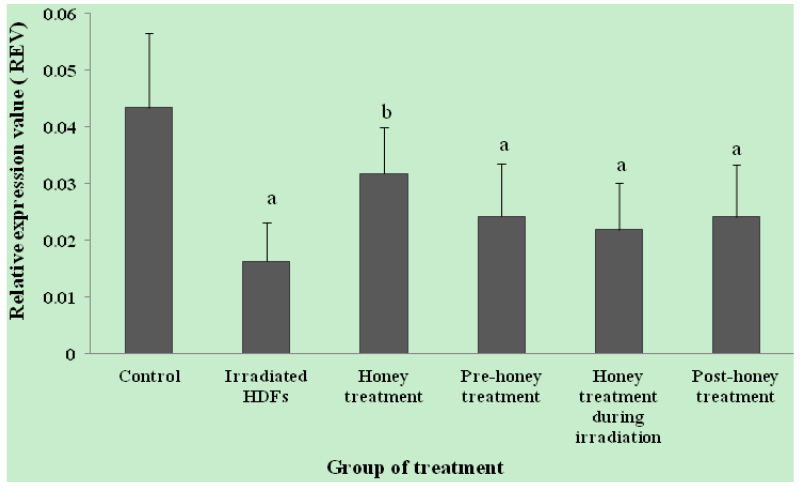
Figure 4. Expression of GPx1 gene in different HDFs treatment groups. HDFs were pre-, during- and post-treated with 6 mg/mL of Gelam honey for 24 h and exposed to 1 Gy of gamma rays. Results are expressed as means + S.D (n = 6). a Denotes p < 0.05 compared to untreated control, b p < 0.05 compared to irradiated